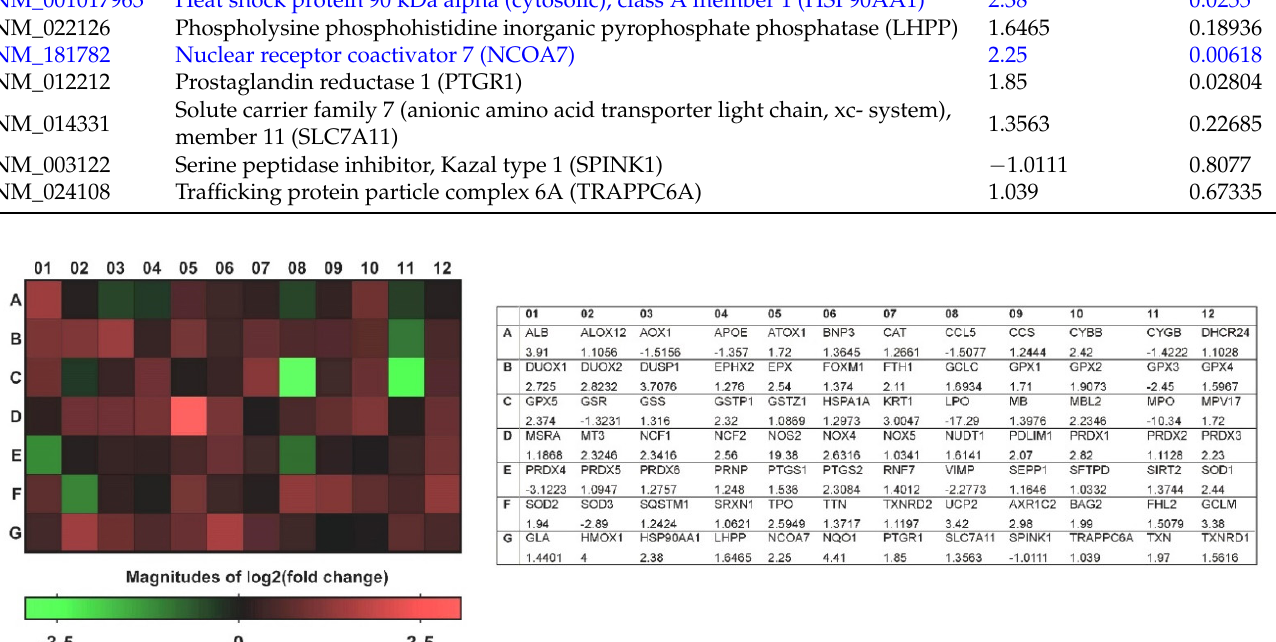
Figure 3. Volcano plot of changes in significant oxidative stress gene expressions. The 84 genes in the human nasal mucosae and NPs associated with oxidative stress were analyzed. The volcano plot displays statistical significance versus fold changes on the y - and x -axes, respectively. The x -axis represents fold changes from the control, whereas the y -axis represents the p -values. The vertical solid line in the middle and the other two vertical dashed lines indicate a one-fold change and a threshold of two-fold changes in gene expression, respectively. Note that the light blue line indicates a p -value of 0.05. The significantly changed genes are located outside the two vertical dashed lines and above the blue line, and they are labeled with their respective gene names.